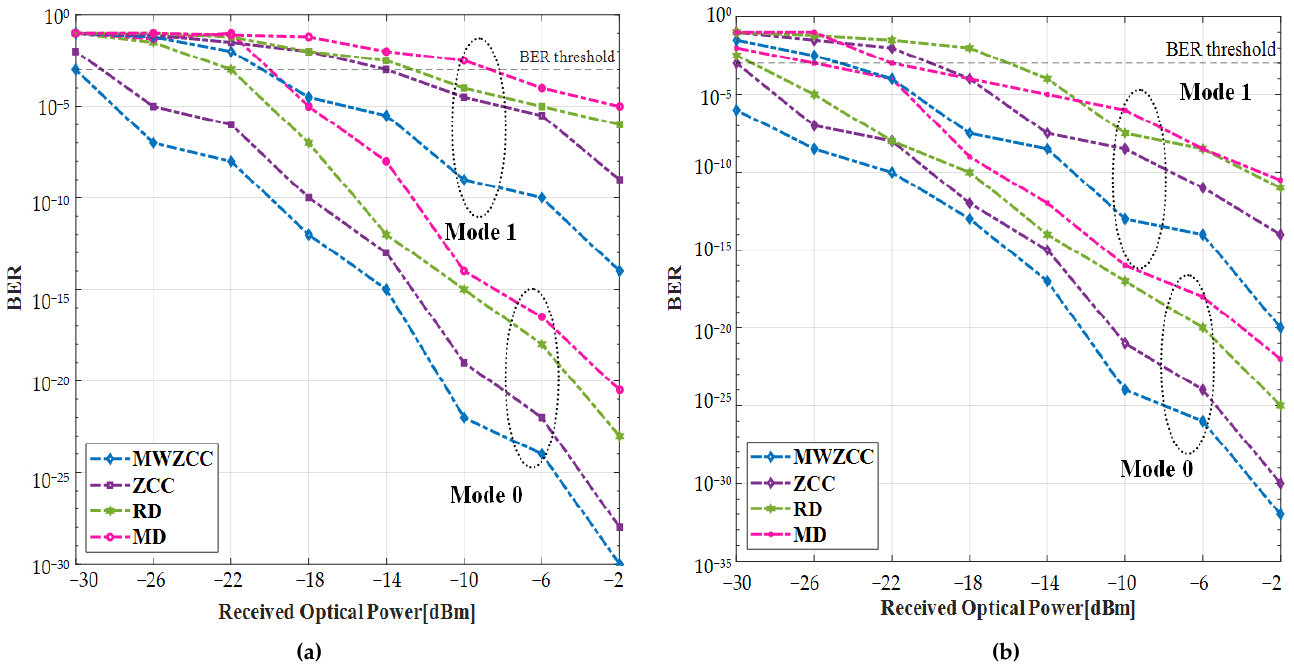
Figure 8. Measured BER vs. received optical power at 10/2.5 Gbit/s data rate over 1 km range for modes 0 and 1 for different codes in ( a ) downstream and ( b ) upstream transmission.